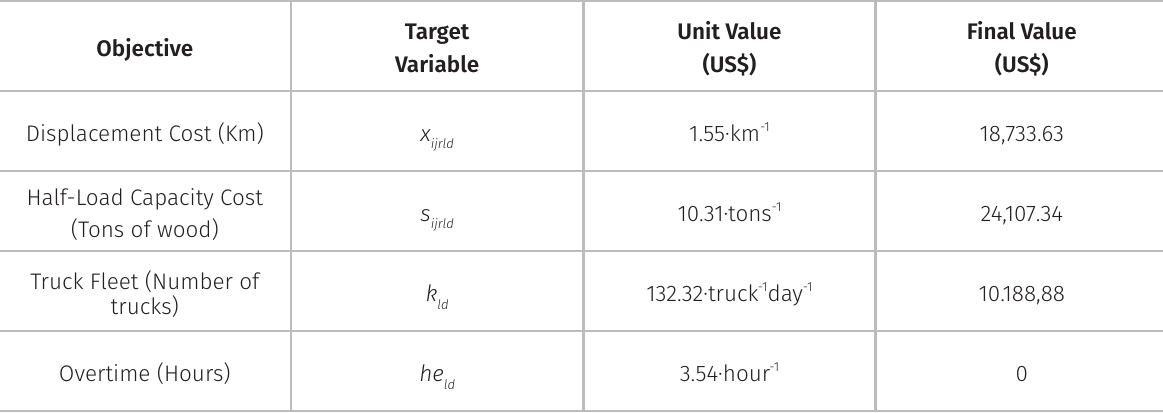
Table II. Financial results from each attained